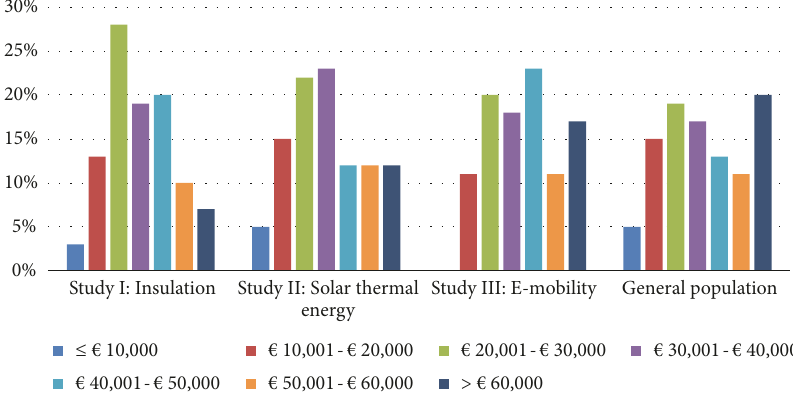
Figure 3: Income groups (in percent) of the samples in comparison to the basic population of German adults. The bars show the net income per